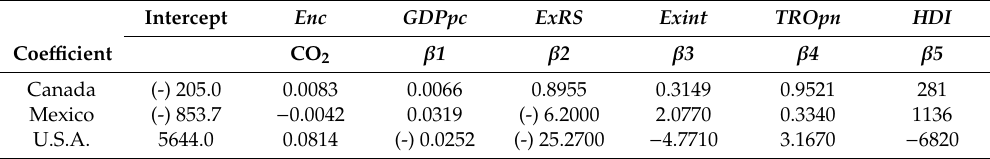
Table 2. Environmental Kuznets Curve (EKC) parameters for NAFTA countries.